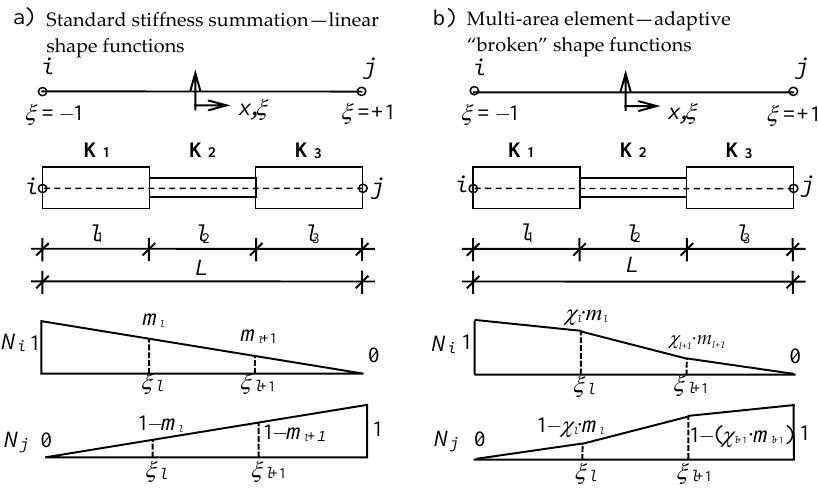
Figure 6. Linear element with variable stiffness-geometric parameters: ( a ) Standard stiffness summation from sub-areas; ( b ) Multi-area element conception.